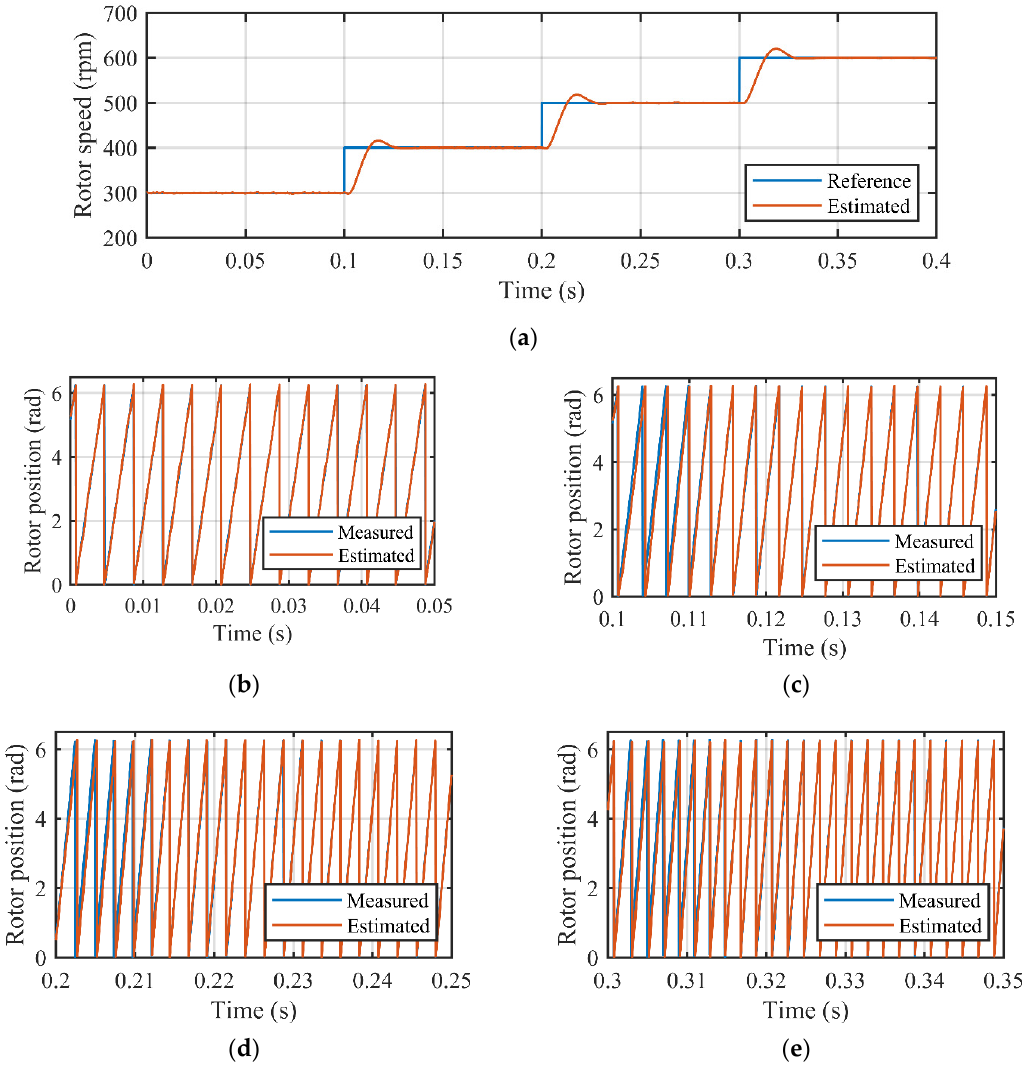
Figure 12. Experimental results of reference speed multi-step strategy, from 300 to 600 rpm, for ( a ) rotor mechanical speed response and rotor electrical position responses at ( b ) 300, ( c ) 400, ( d ) 500, and ( e ) 600 rpm.